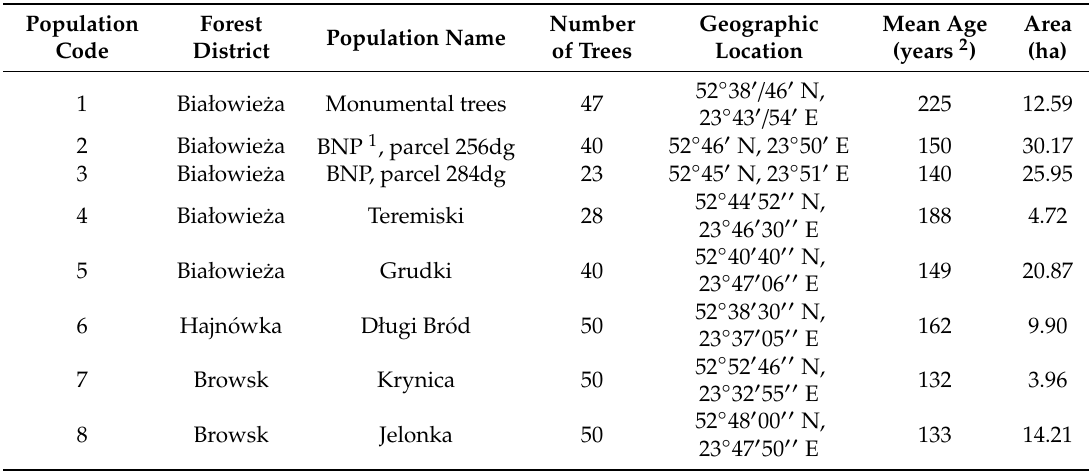
Table 2. Geographical characteristics of the analyzed populations in